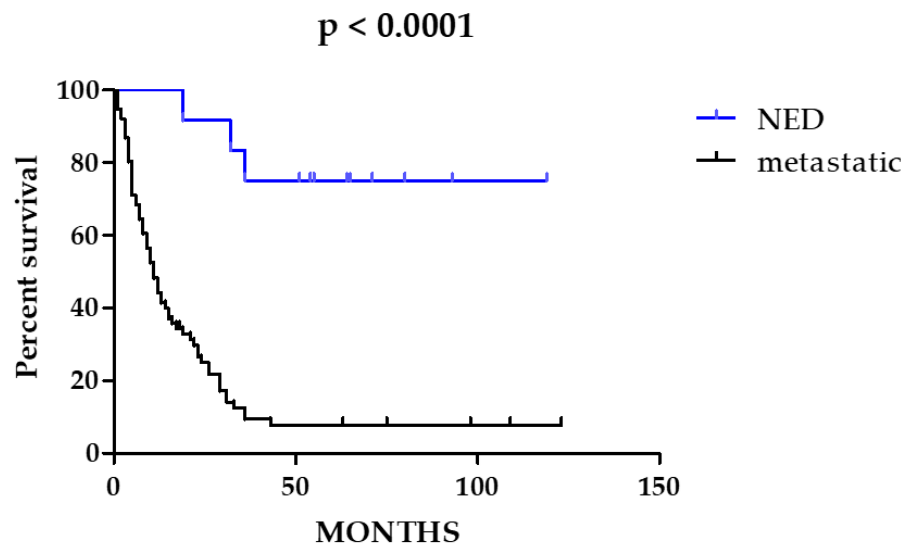
Figure 4. Overall Survival (OS) analysis of metastatic versus non-metastatic CRC patients. In blue, the survival curve of non-metastatic patients (no evidence of disease, NED). In black, the survival curve of metastatic patients.